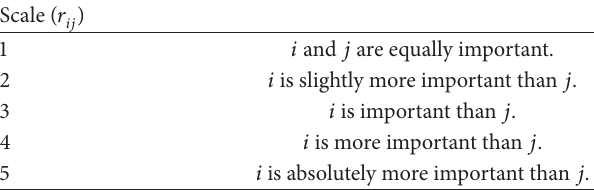
Table 2: Customer needs relative weight